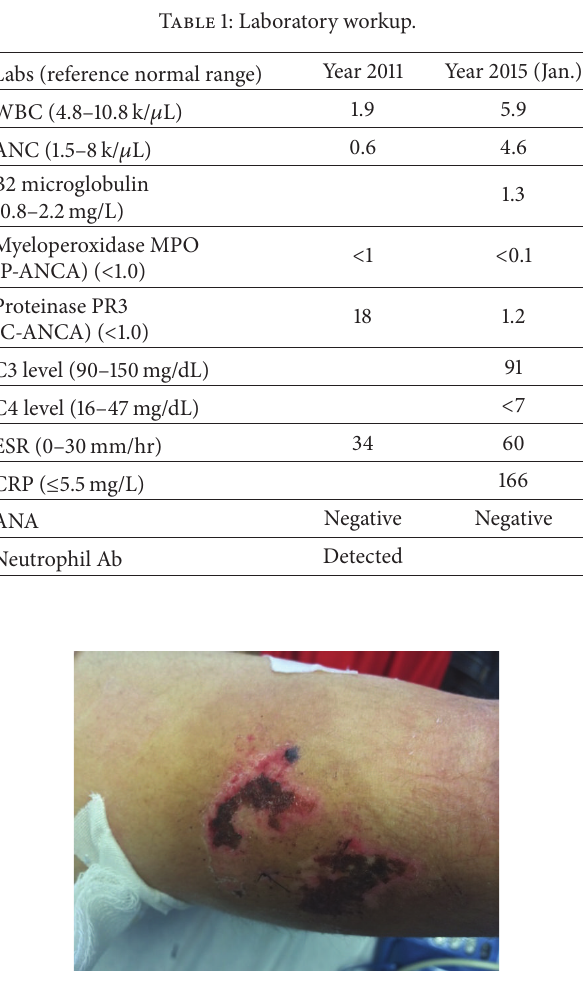
Figure 1: Multiple necrotic purple lesions on arms.